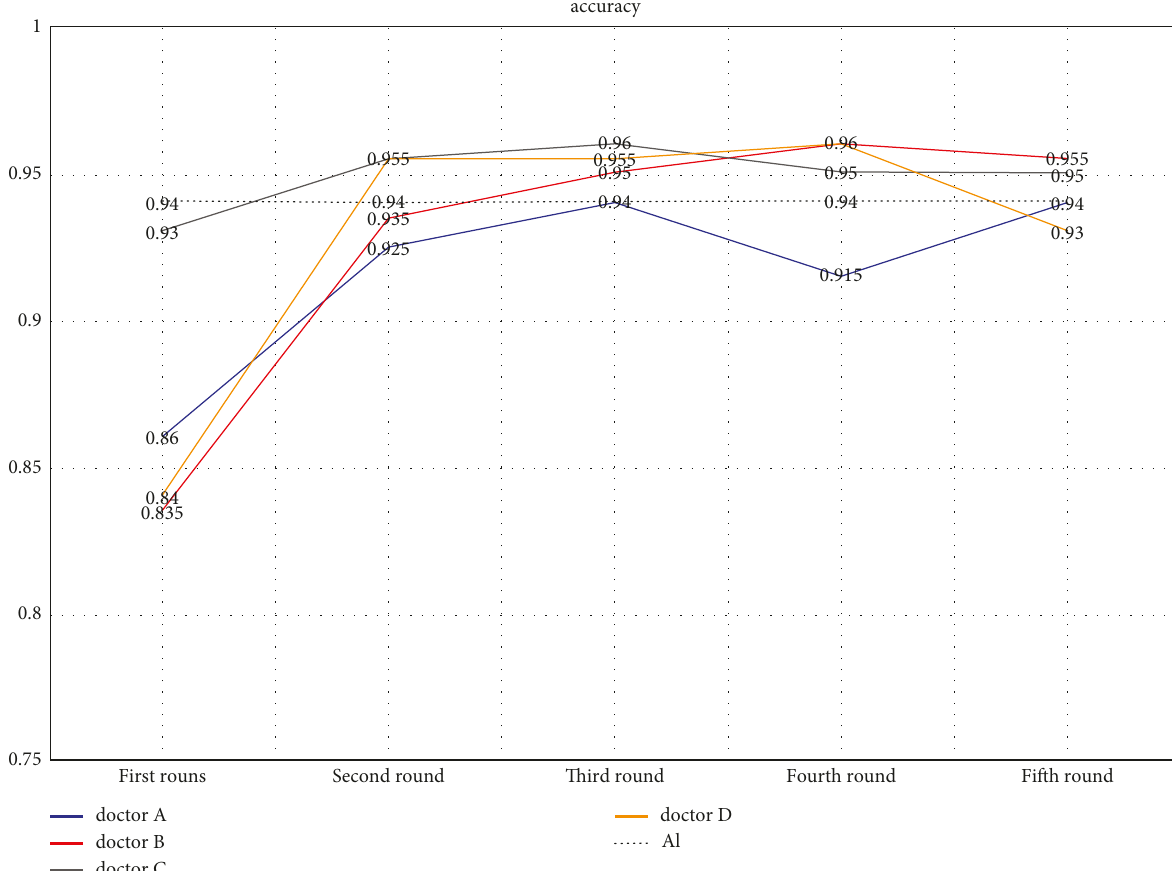
Figure 2: In the first round, the accuracy of 4 doctors was lower than that of AI. In the second round, with the help of AI, the accuracy of doctor C and doctor D was higher than that of AI, while the other 2 doctors had a lower accuracy with the help of AI. In the third round, with the help of AI, the accuracy of doctor A was the same as AI, while the accuracy of the other three doctors with the help of AI was higher than AI. In the fourth round, without the help of AI, the accuracy of doctor A was lower than AI, while the accuracy of the other three doctors (Doctor C did not have the help of AI, while doctor B and doctor D had the help of AI.) was higher than AI. In the fifth round, without the help of AI, the accuracy of doctor D was lower than AI. With the help of AI, the accuracy of doctor A was the same as AI, while the other two doctors (Doctor C did not have the help of AI, while doctor B had the help of AI.) had a higher